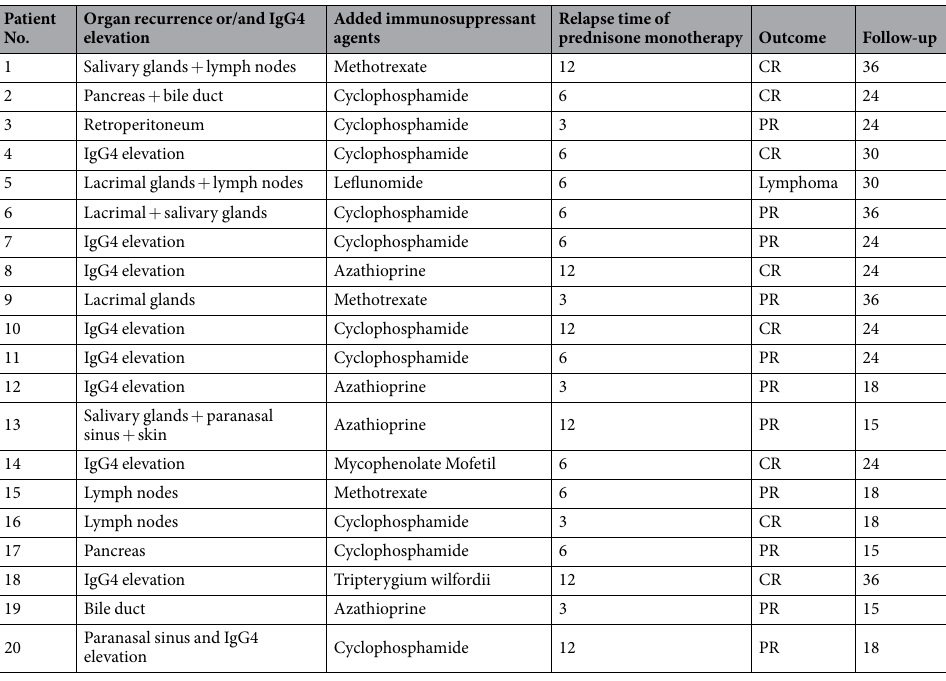
Table 4. Follow-up and outcomes of relapsed IgG4-RD patients in Group